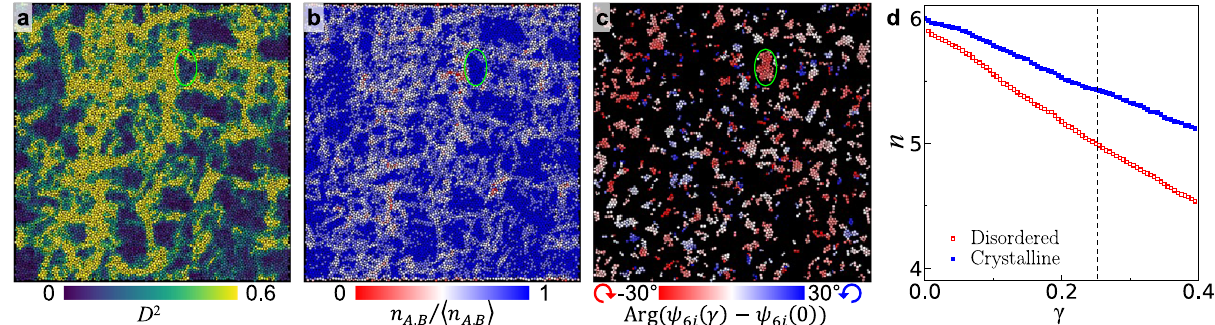
Fig. 5 Microstructure changes during plastic deformation at strain γ = 0.25. a The spatial distribution of nonaf fi ne displacement D 2 . b The spatial distribution of the number of long-lived neighbours of each particle n A , B normalised by the average number 〈 n A , B 〉 , which anticorrelates with ( a ). c The rotation angle of crystalline particles when γ increases from 0 to 0.25. Clockwise rotations (red) dominate. Amorphous particles are in black. The green ellipses in ( a – c ) mark a crystalline grain that clockwise rotates (Fig. 4l) to accommodate the plastic fl ow. d The mean number of long-lived neighbours n for crystalline and disordered